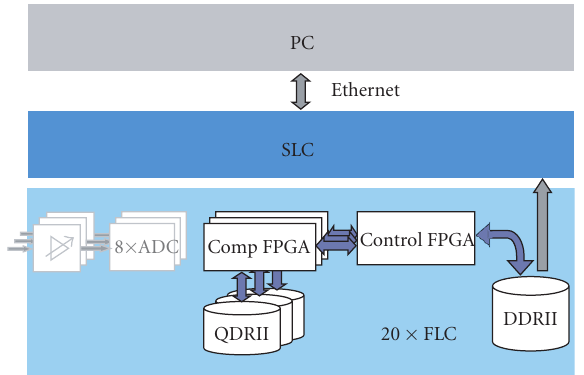
Figure 5: Detailed data-flow of one FLC during the newly created processing mode: as the data sets were previously stored in DDRII memory, we transferred them back to QDRII memory and processed them in the computing FPGAs. Finally, we stored the resulting data again in DDRII memory.